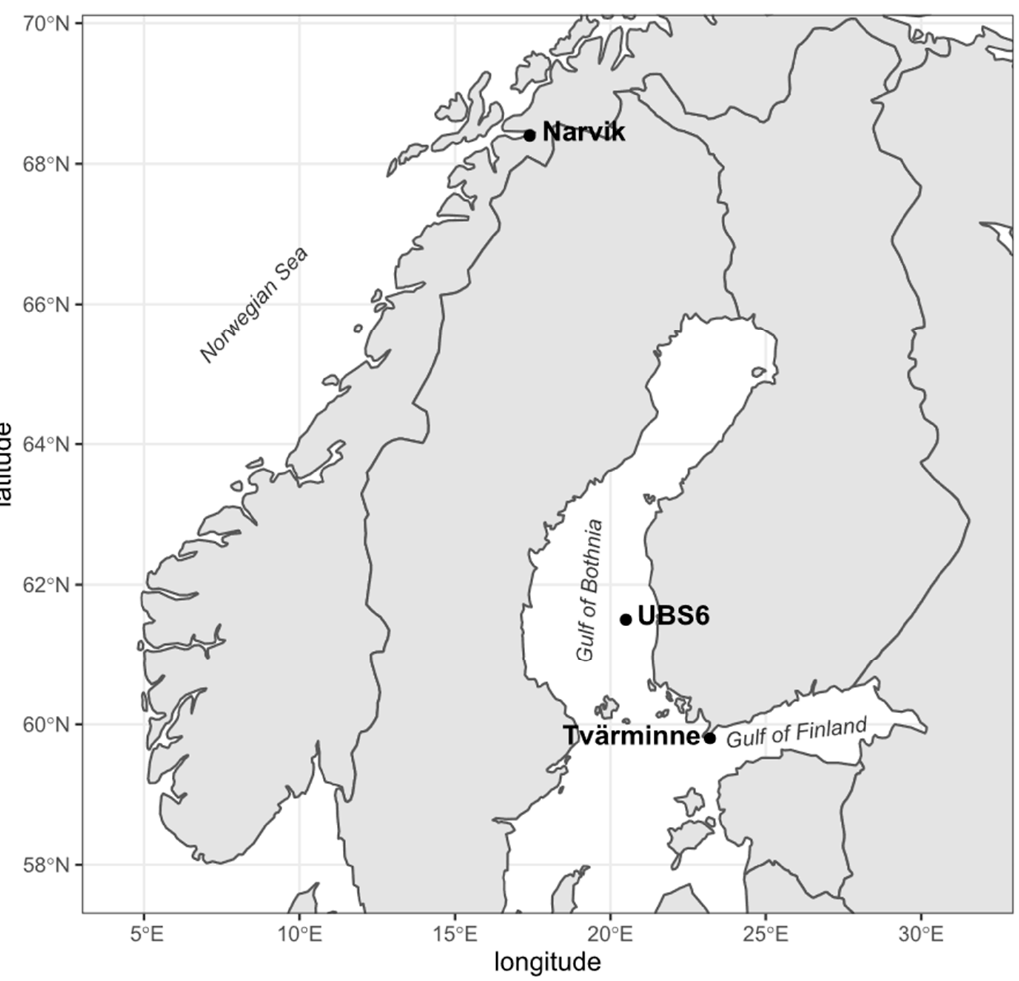
Figure 1. Map of sampling sites. Sampling locations in Tvärminne Zoological Station, UBS6 and Narvik are indicated with black circles.